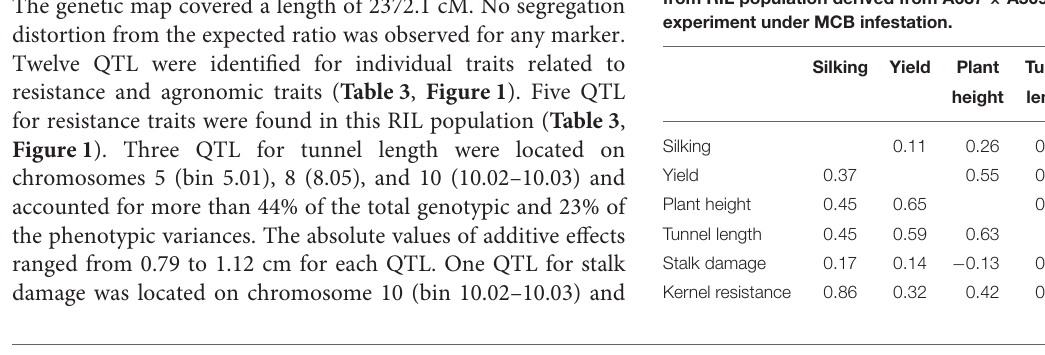
TABLE 1 | Means and their standard errors ( ± SE), rank, and heritabilities ( h 2 ) of the RIL population derived from A637 × A509 for resistant and agronomic traits evaluated in a 2 years experiment under MCB